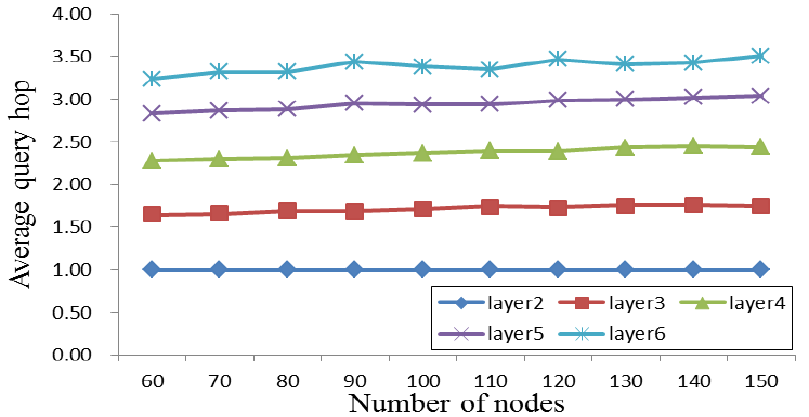
Figure 5. Average query hop in the mesh-shaped topology.